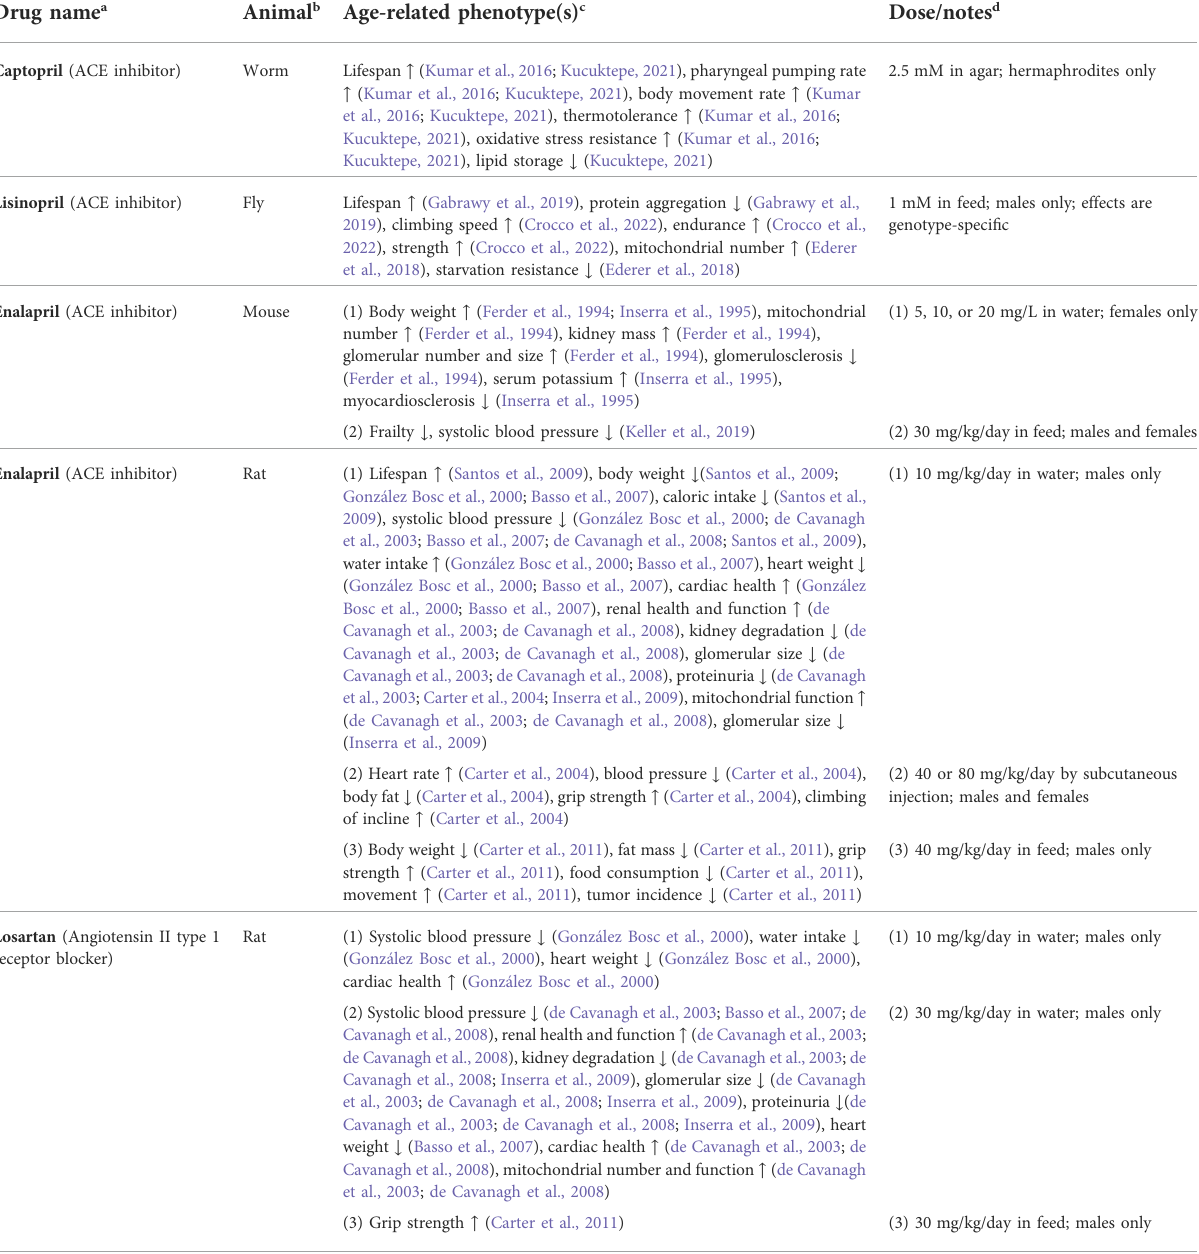
TABLE 1 Pharmacological inhibition of the RAS system and effects on age-related